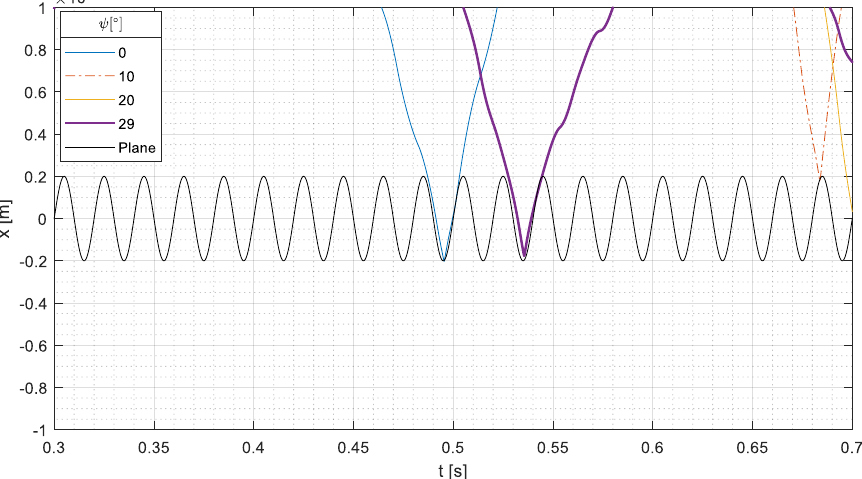
Figure 9. Numerical results, displacement of the cylindrical part along the track, impact with small relative velocity at 𝑡 = 0.49, 𝜓 = 0°, 𝜃 = 3° , 𝑓 𝑣 = 0.005, 𝜇 𝑐 = 0.3,𝜇 𝑠 = 0.6 .